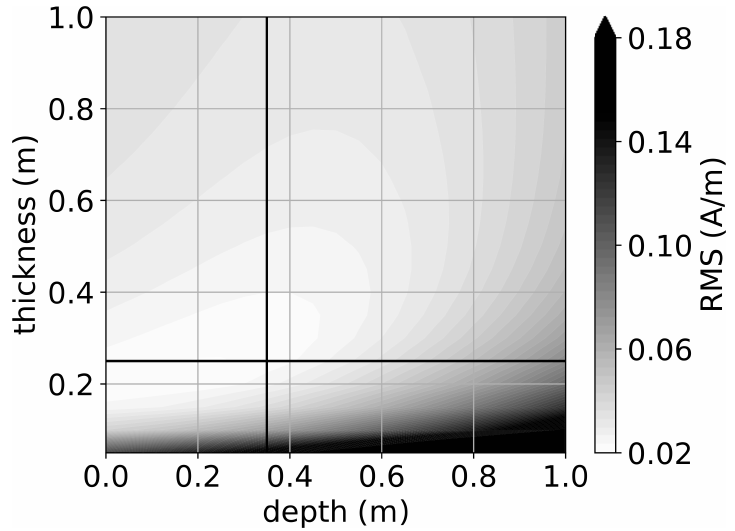
Figure 7. Root mean square (RMS) error between reference model and inverse filtering results for varying depth and thickness values of the layer in the filter. The black lines mark the correct values for depth (0.35 m) and thickness (0.25 m).